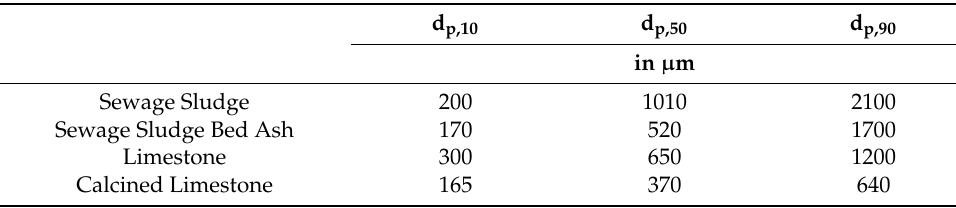
Table 3. Particle sizes of fuel and bed materials.